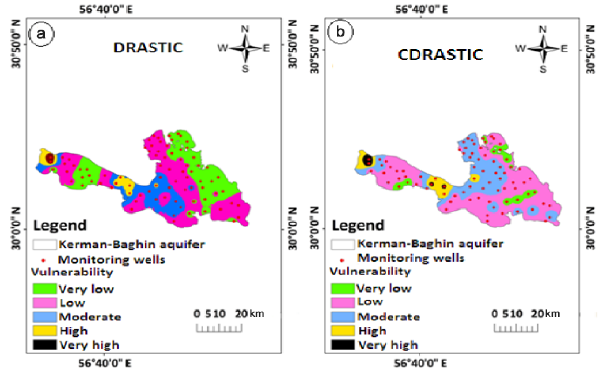
Figure 6. Vulnerability maps of the Kerman–Baghin aquifer by DRASTIC and CDRASTIC indices. Table 8. Statistical results of MRSA in the DRASTIC